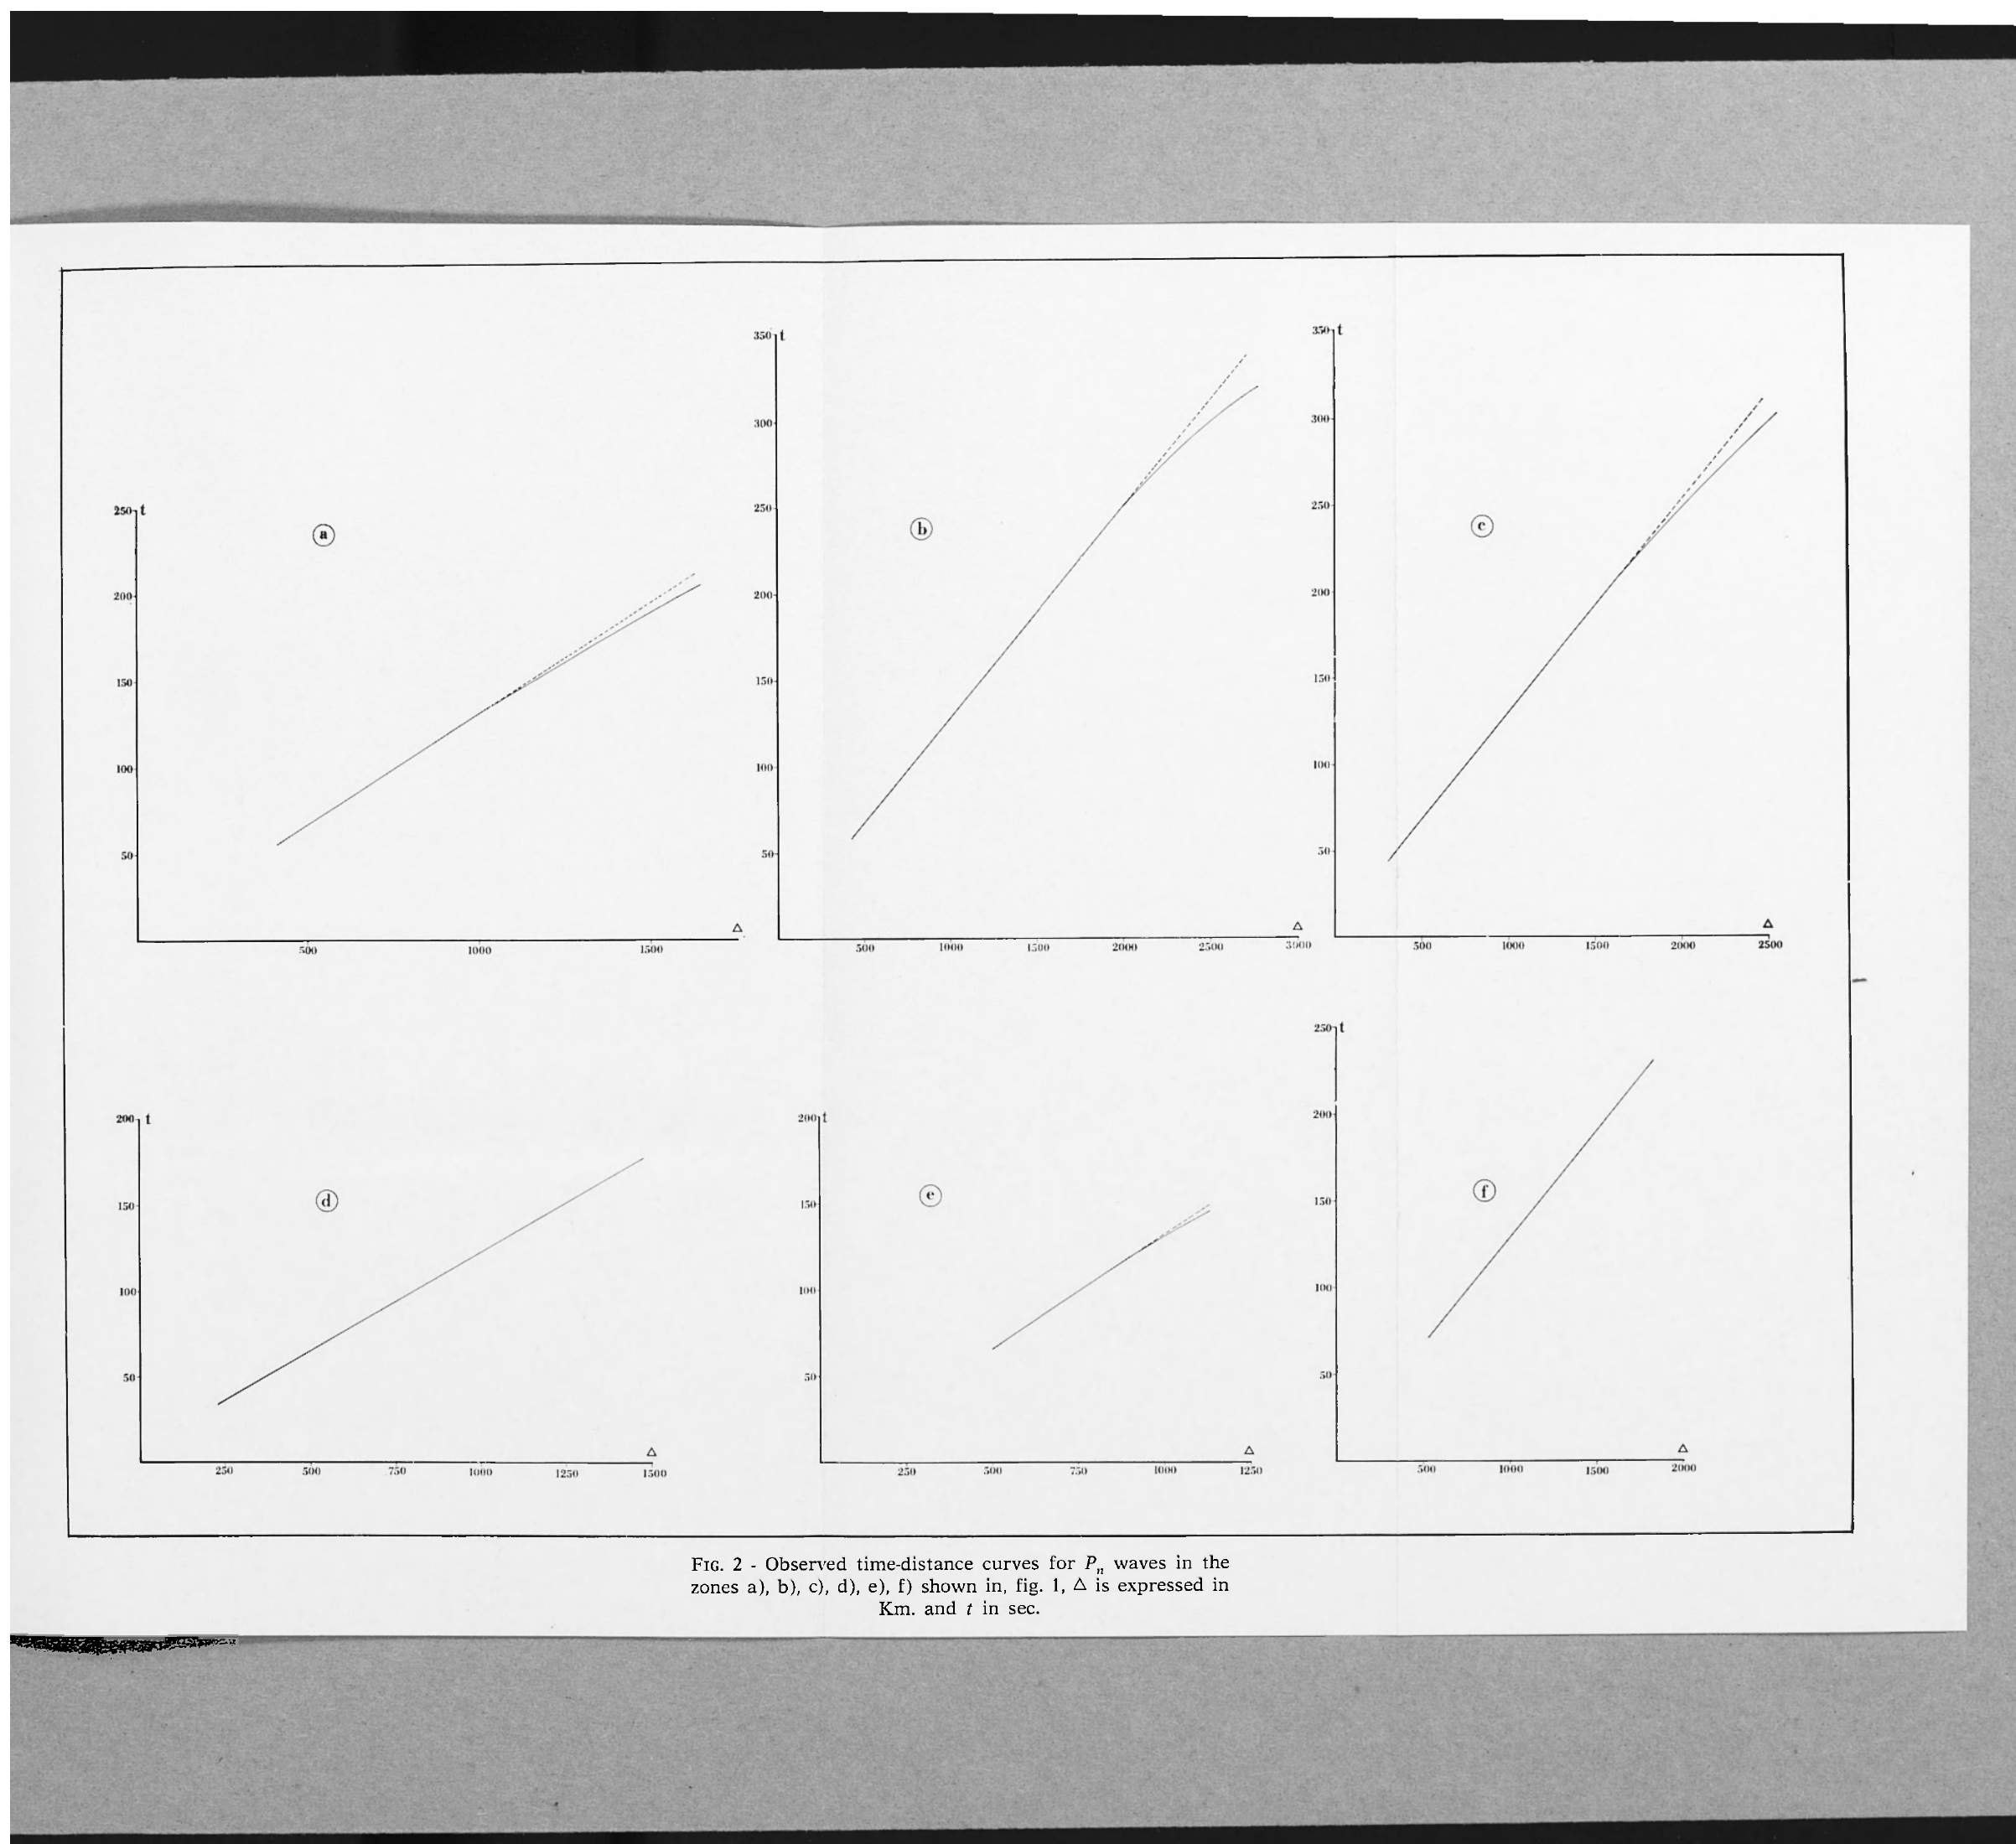
FIG. 2 - Observed time-distance curves for P n waves in the zones a), b), c), d), e), f) shown in, fig. 1, A is expressed in Km. and t in